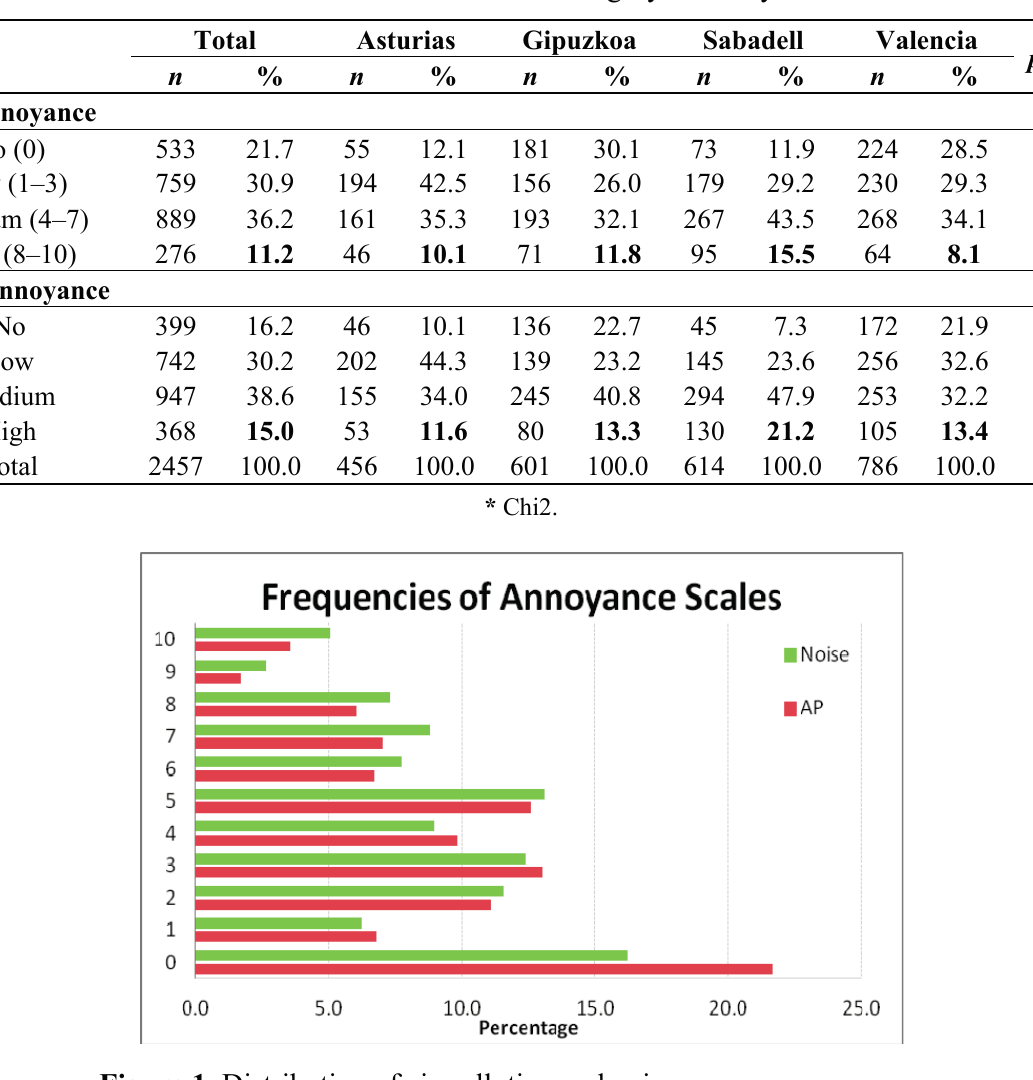
Figure 1. Distribution of air pollution and noise annoyance